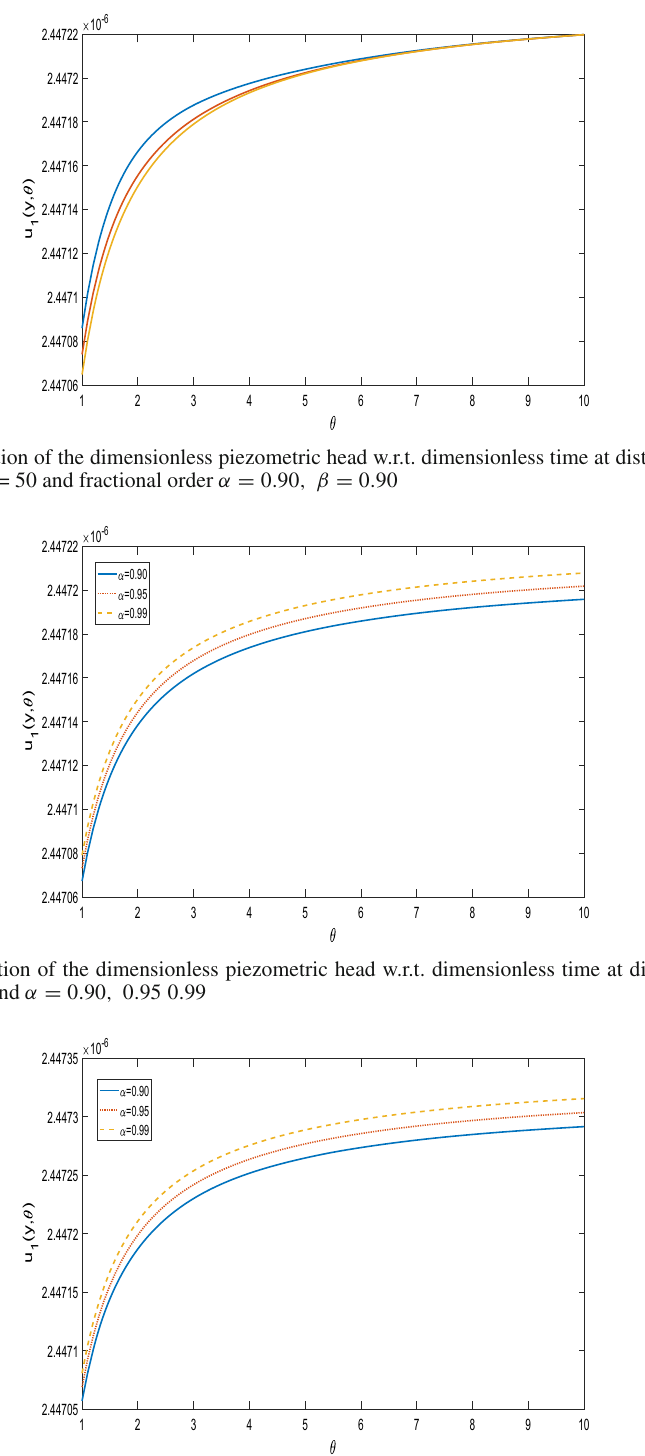
Fig. 6 Graphical representation of the dimensionless piezometric head w.r.t. dimensionless time at distance y = 5.5. for fixed β = 0 . 90 , ζ = 10 , η = 8 and α = 0 . 90 , 0 . 95 0 .